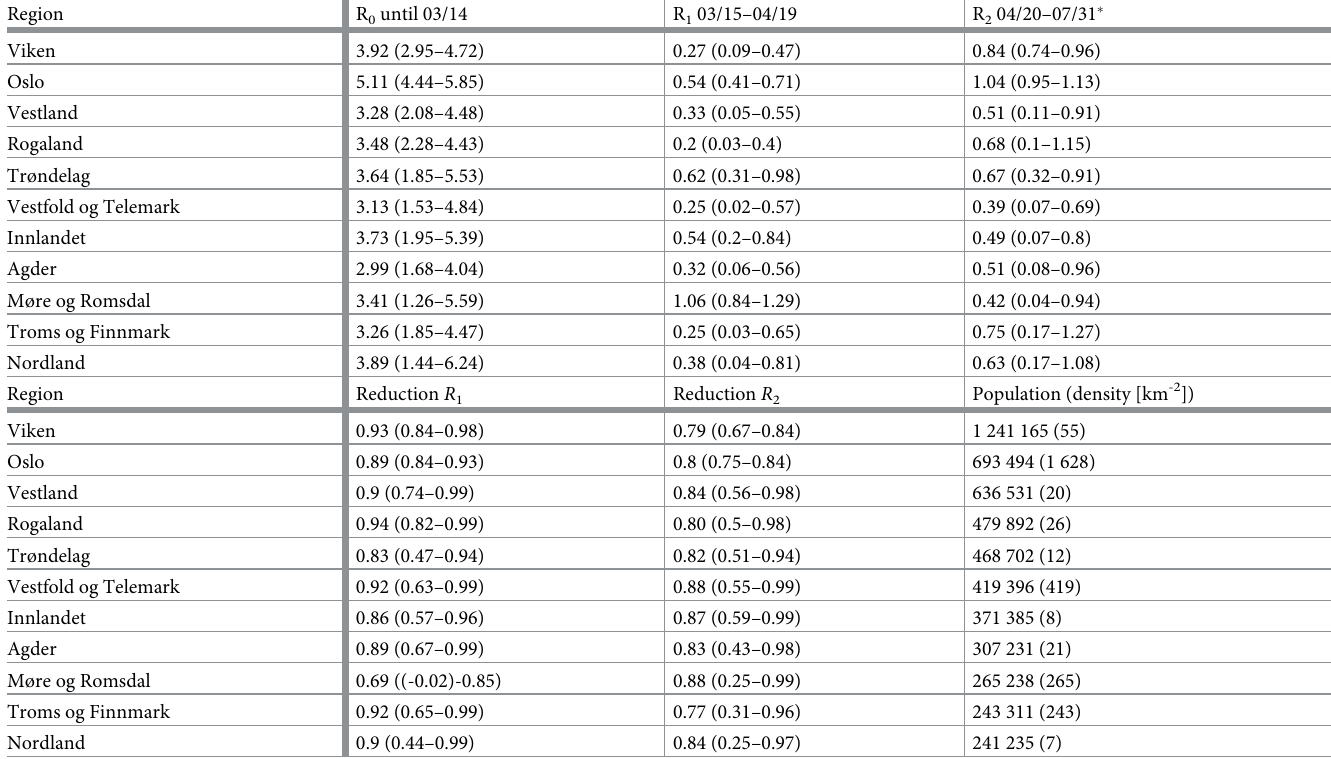
Table 1. Estimated reproduction numbers.